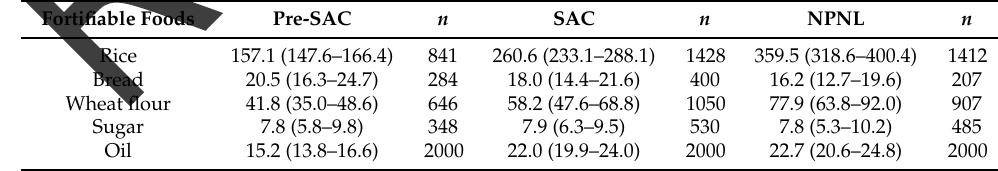
Table 4. Mean (95% CI) consumption of rice, bread, wheat flour, sugar, and oil by consuming population groups